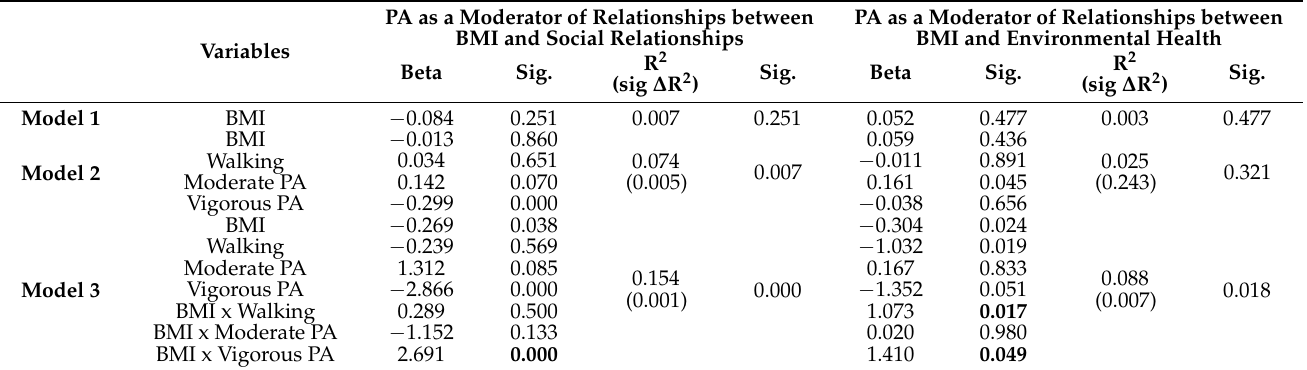
Table 3. Physical activity as a moderator of the relationships among BMI, social relationships, and environmental